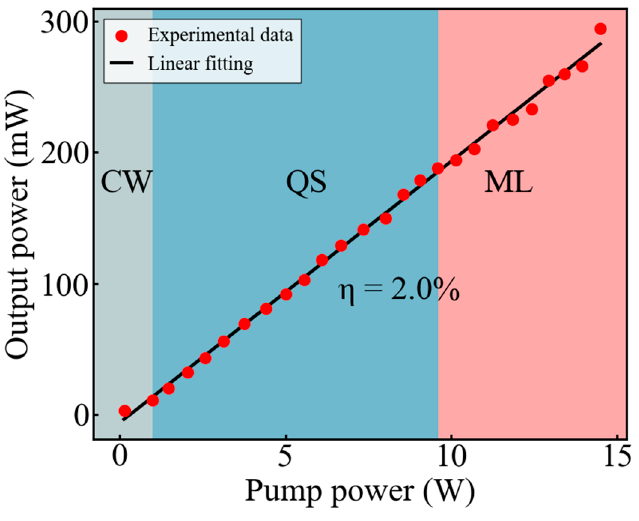
Figure 2. Output power as a function of pump power. CW, continuous wave; QS, Q-switching; ML, mode locking.